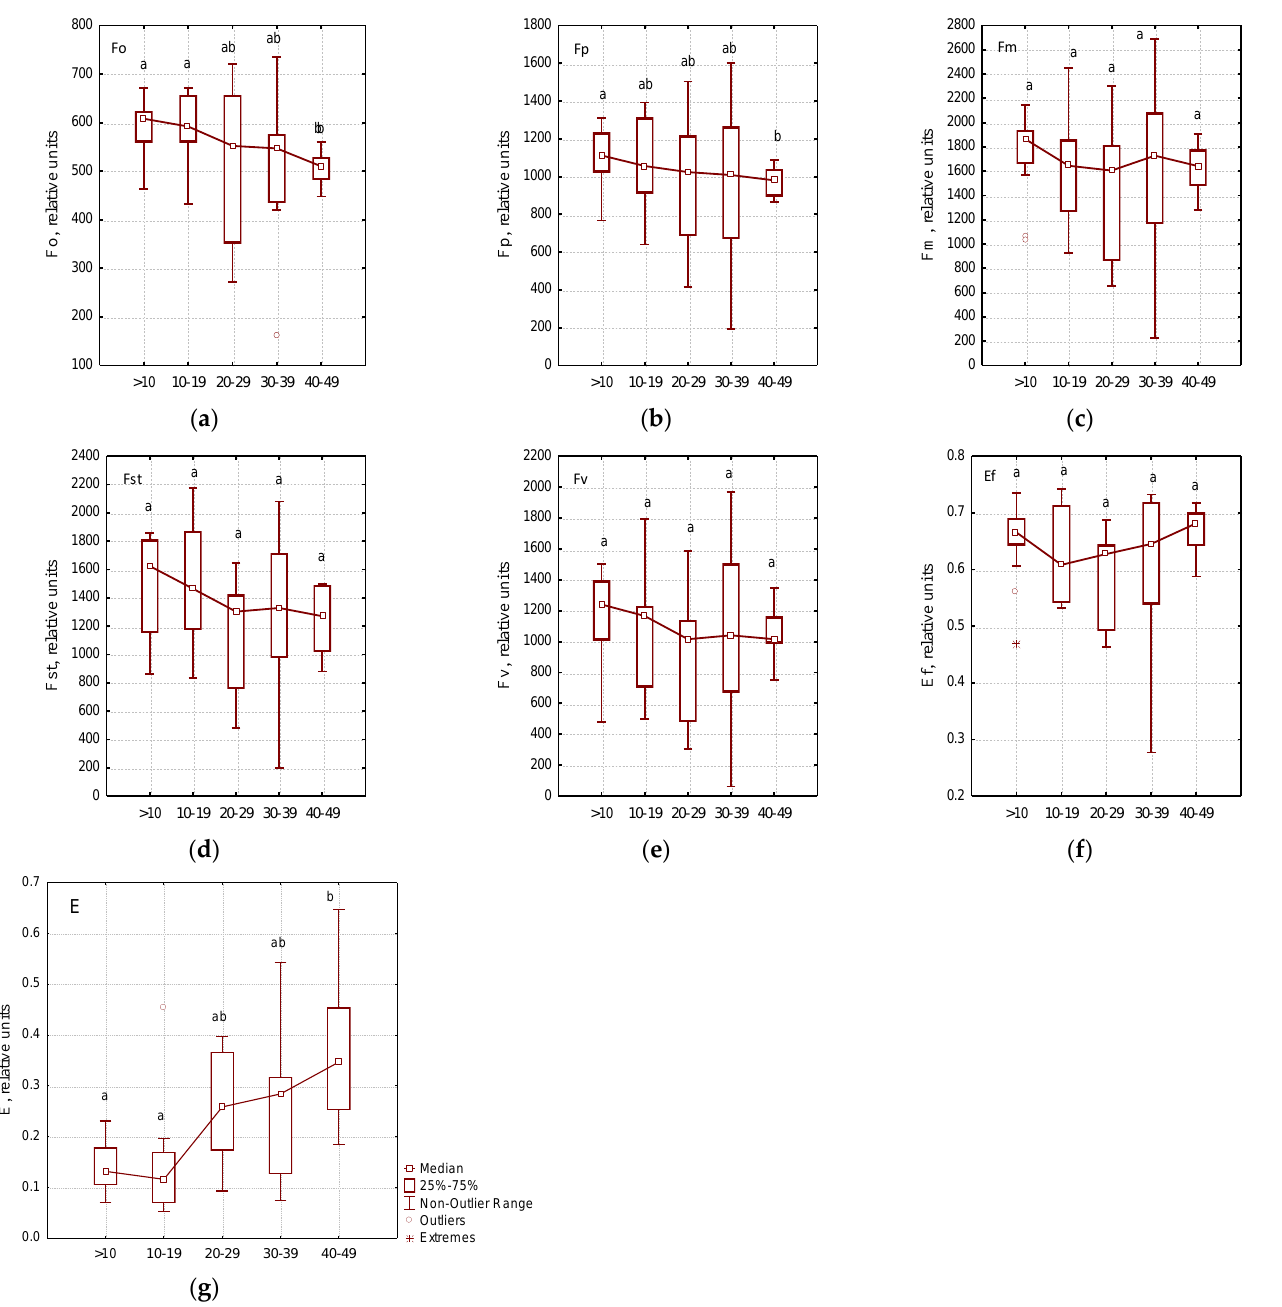
Figure 3 . Measurements of physiological parameters of photosynthesis depending on the leaf damage degree: ( a ) — F 0 — the initial value of fluorescence induction after switching on irradiation, ( b ) — F p — the value of fluorescence induction “ plateau ” , ( c ) — F m — the maximum value of fluorescence induction, ( d ) — F St — the steady value of fluorescence induction after light adaptation of the leaf of the plant, ( e ) — F V — variable chlorophyll fluorescence, ( f ) — Ef — the maximum efficiency of primary photosynthesis processes, ( g ) — E — efficiency coefficients of photochemical processes; different letters within each figure indicate significant differences between the groups ( p < 0.05) according to the results of Tukey test, n = 7 .